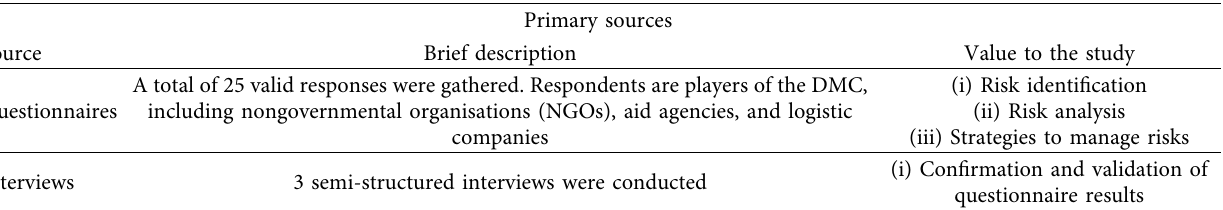
Figure 2: Research framework—integration of the literature relating to the source of risks, disaster management cycle, and supply chain risk mitigation strategies. Table 3: Empirical data